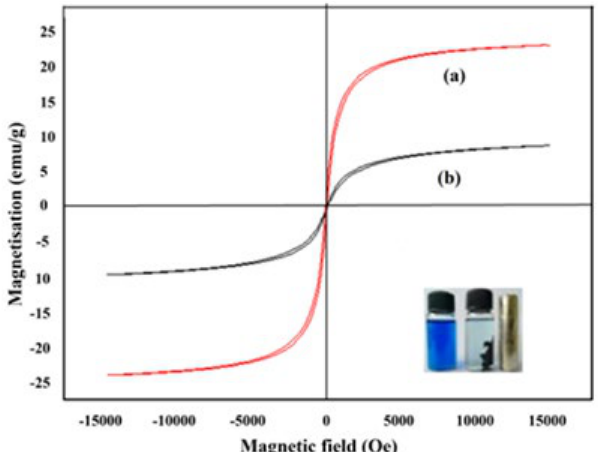
Fig. 8: Magnetic hysteresis loop of (a) CoFe Fig. 8 Magnetic hysteresis loop of (a) CoFe 2 O 4, and (b) NG@CoFe 2 O 4